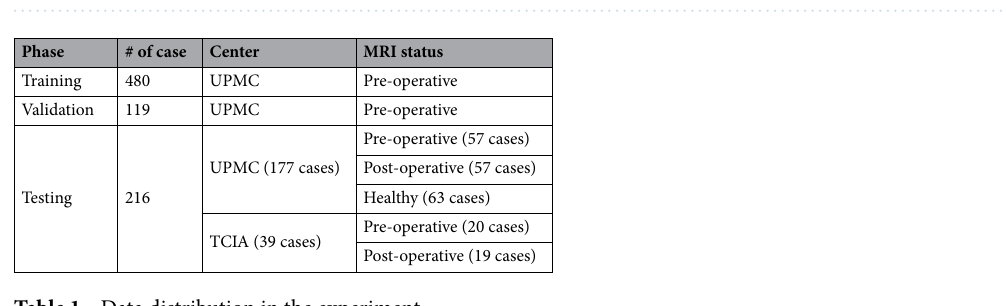
Table 1. Data distribution in the